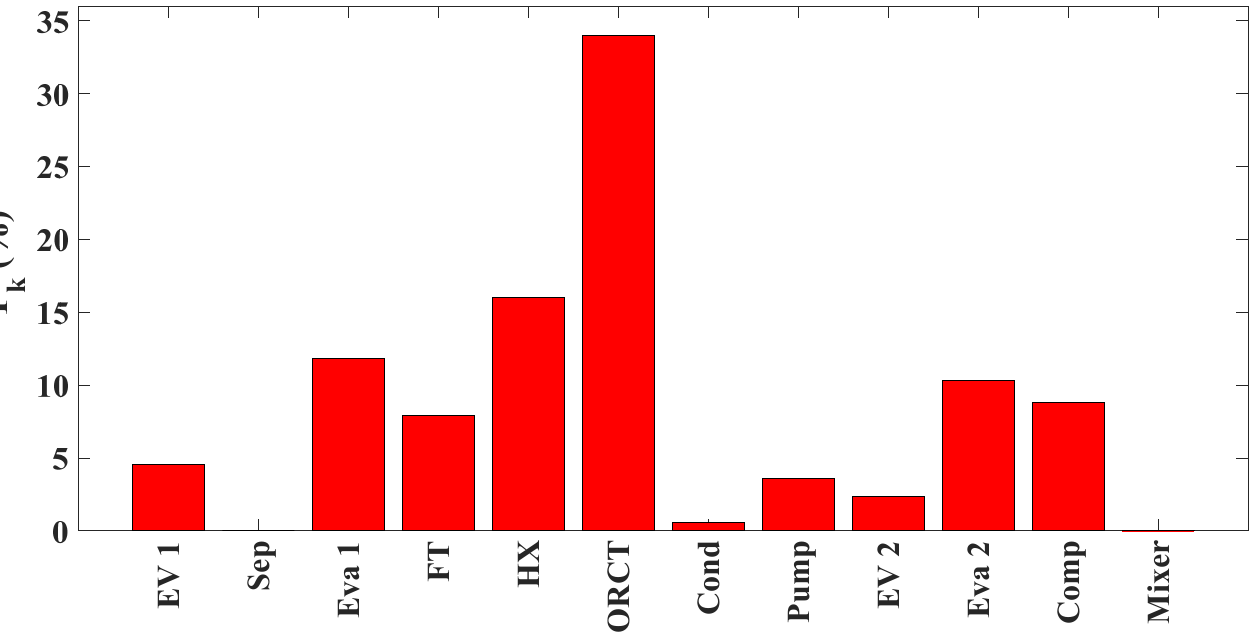
Figure 11. The exergy destruction ratio of all equipment.